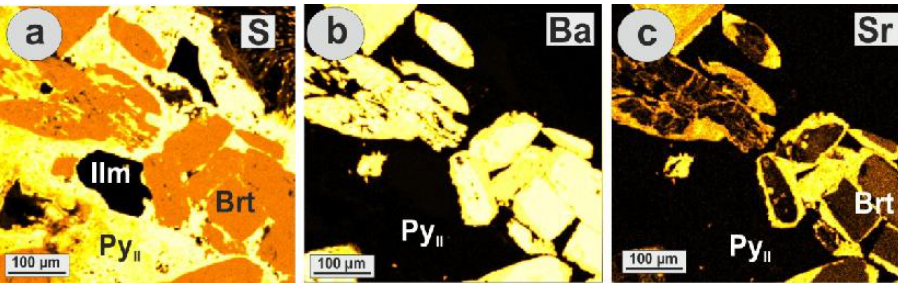
Figure 10. EDS maps of ( a ) S, ( b ) Ba and ( c ) Sr from a pyrite (Py)‐barite (Brt)–Ilmenite (Ilm) assem- blage, showing significant variations of Sr between barite cores and rims (ML7A). Alunite group minerals (Figure 6c,g,h) at Paleochori Bay are present as solid solutions between alunite/natroalunite and jarosite/natrojarosite (Table 4, Figure 11) (e.g., [94]). The alunite-jarosite solid solutions at Paleochori are characterized by varying